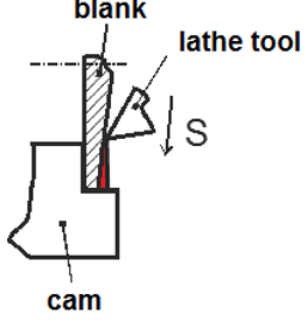
Fig. 2. Trimming the end of the disc when fixed in a three-cam chuck (filling marked a dangerous area during processing).